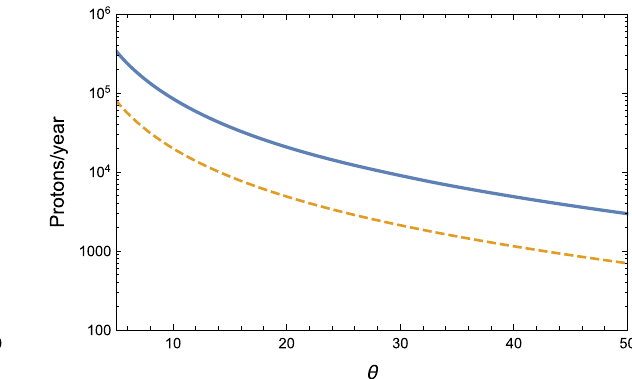
TeV, m = 1000 GeV and ρ = 0 . 5 (solid) and ρ = 1 (dashed); right: for ρ = 0 . 5, k = 7 TeV, m = 1000 GeV (solid) and m = 1500 GeV